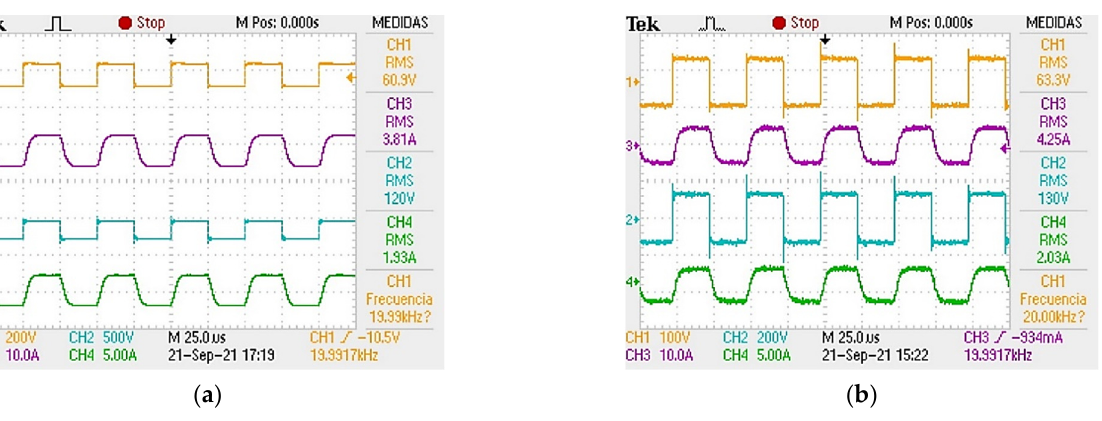
Figure 13. MFT input and output voltages and currents (25% P nom ): ( a ) Nanocrystalline, ( b ) Ferrite.